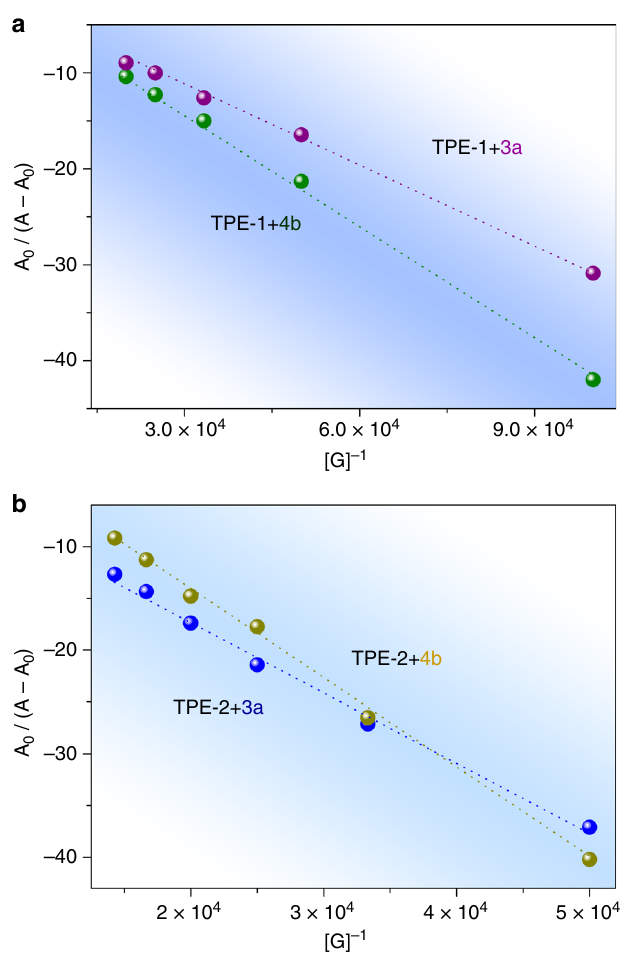
Fig. 4 Benesi − Hildebrand plots. a TPE -1 titration with 3a and 4b ; b TPE -2 titration with 3a and 4b . The plots were obtained by using a UV − Vis titration experimental method in CH 3 CN at r.t